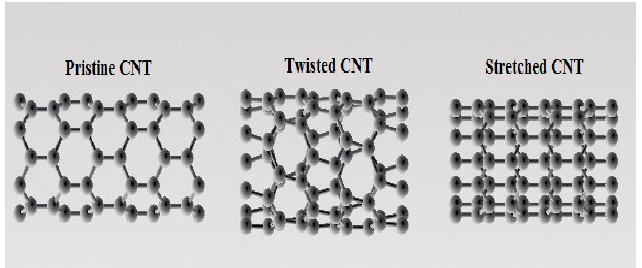
Figure 3. Pristine, twisted, and stretched (in x ‐ y) CNTs.